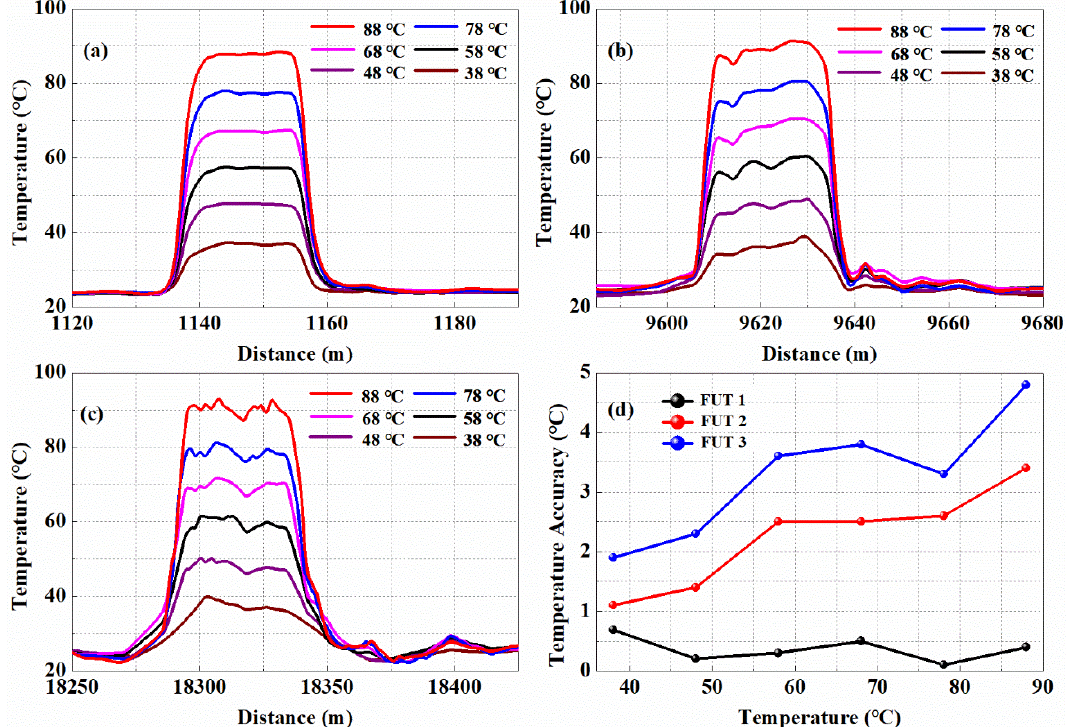
Figure 6. ( a ) Results of temperature measurement in detail of FUT 1; ( b ) Results of temperature measurement in detail of FUT 2; ( c ) Results of temperature measurement in detail of FUT 3; ( d ) Results of temperature measurement accuracy of FUT 1, FUT 2, and FUT 3.